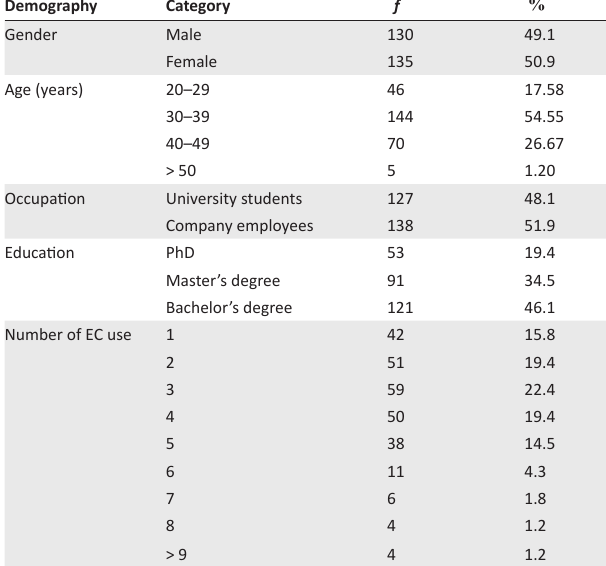
TABLE 2: Demography of participants.